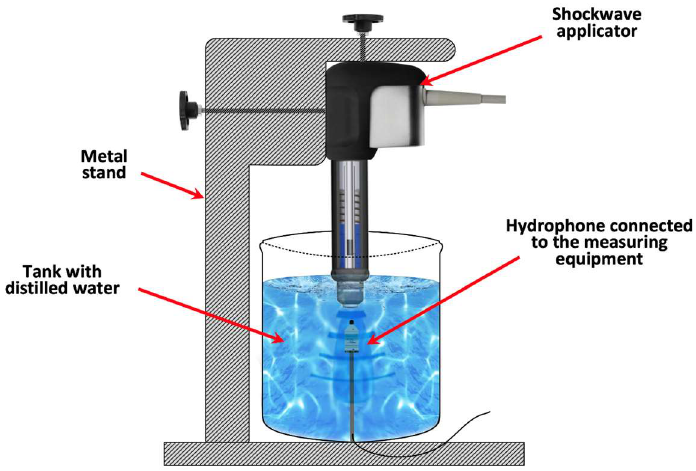
Figure 8. Test bench with a hydrophone and transmitter immersed in the water tank.